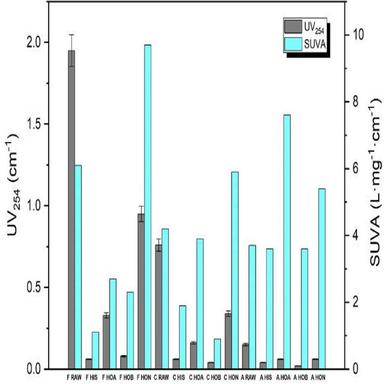
Characterization of UV254 and SUVA for dissolved organic components during the stepwise process (F-filtration process, C-coagulation process, A-adsorption process, RAW-the raw bio-treated coking wastewater, HOA-hydrophobic acid, HOB-hydrophobic base, HON-hydrophobic neutral, HIS-hydrophilic substances).